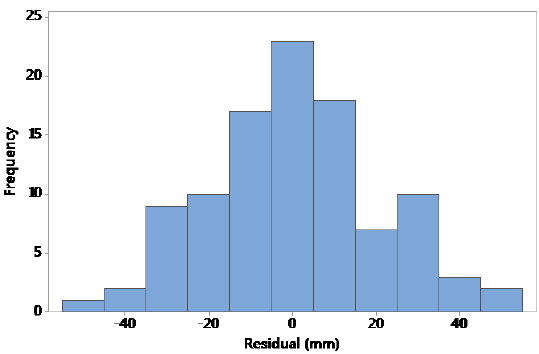
Figure 3: Histogram of residuals. Number of yearly averaged obser- vations is